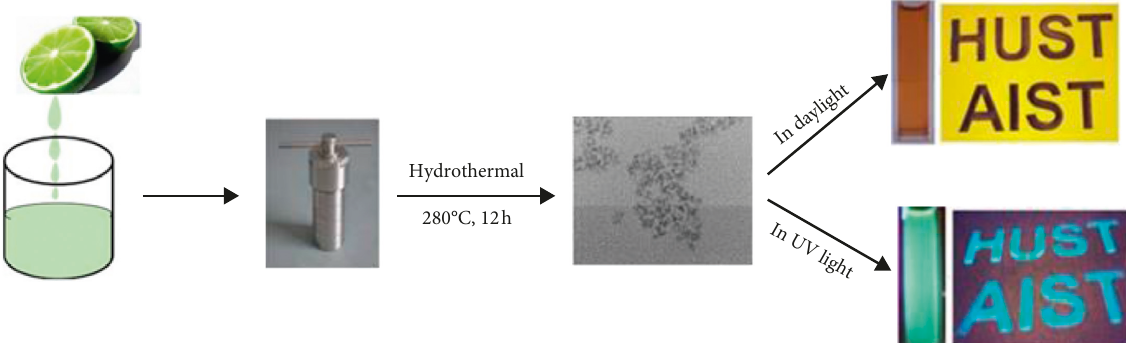
Figure 1: Schematic description of hydrothermal process of lemon juice for synthesis of C-dots and HUST and AIST characters building from C-dots under visible light and UV